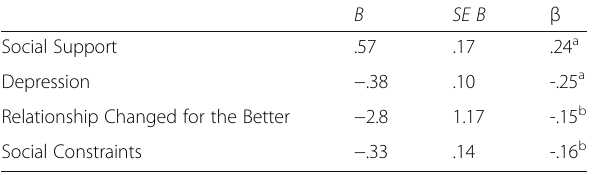
Table 3 Regression Analysis for Marital Satisfaction in Partners of Young Breast Cancer Survivors